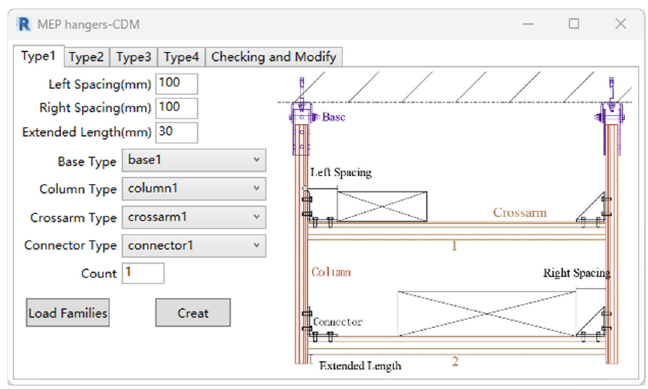
Figure 12. The user interface of the MEP hanger-CDM System.